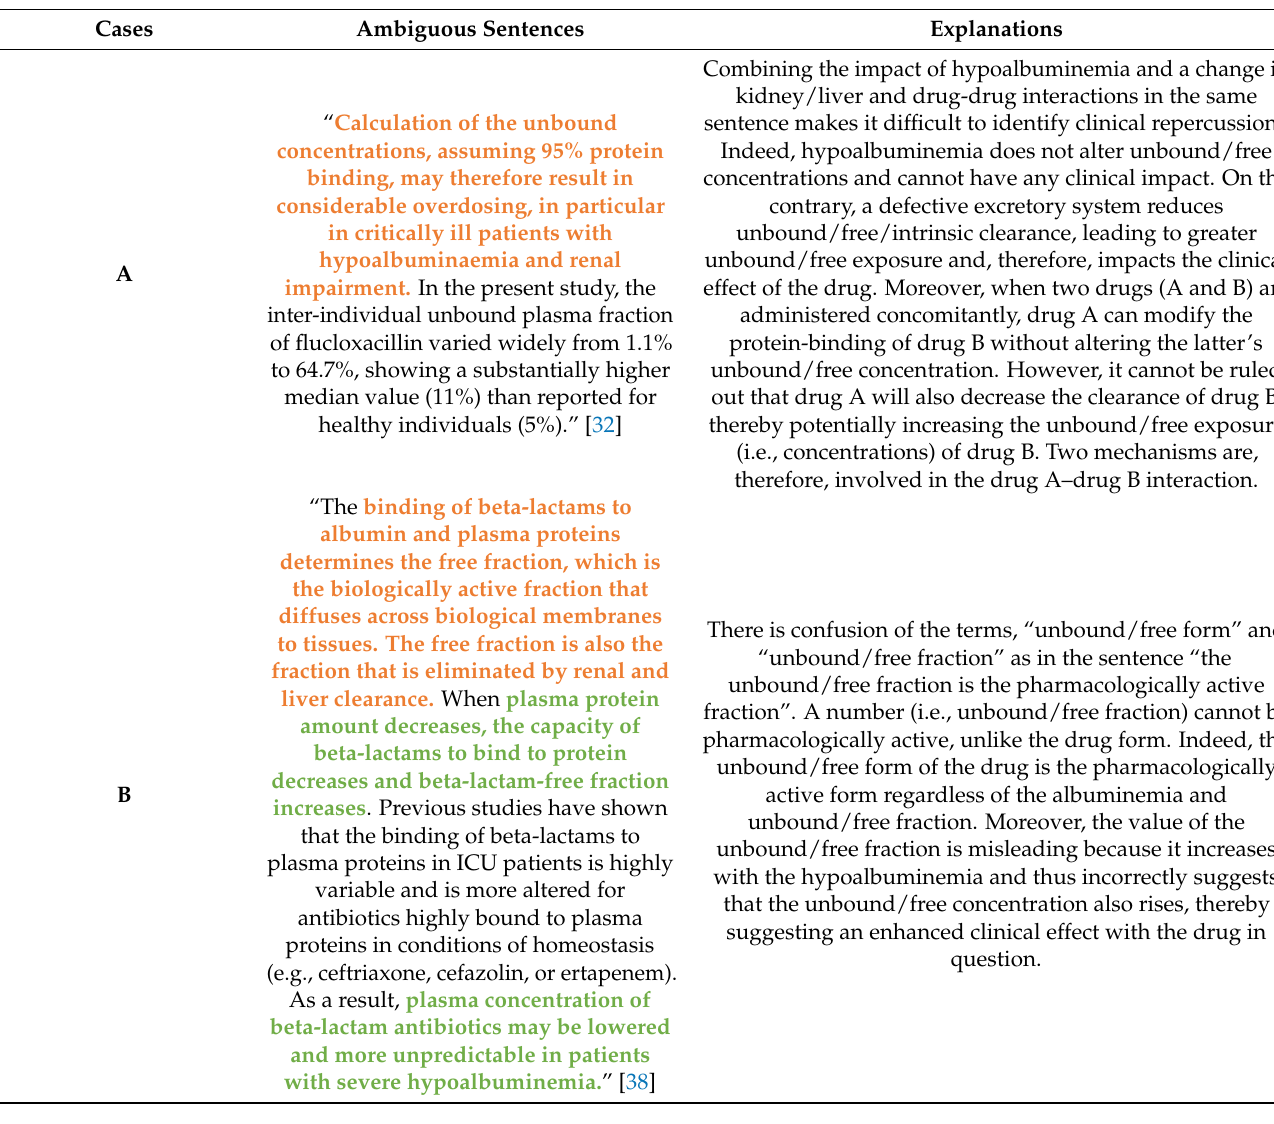
Table 2. Examples of ambiguous explanations found in the